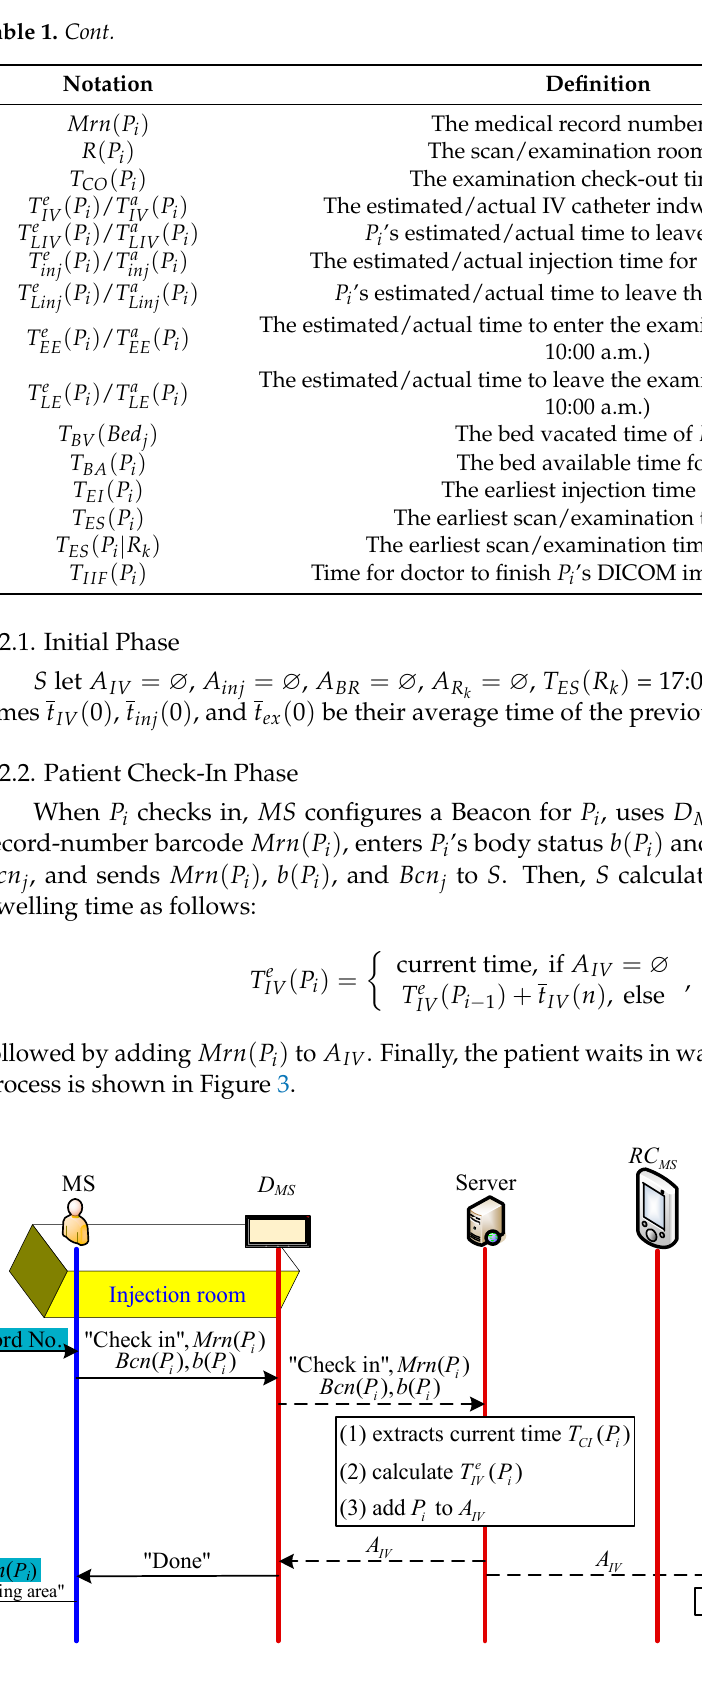
Figure 3. Check-in process.